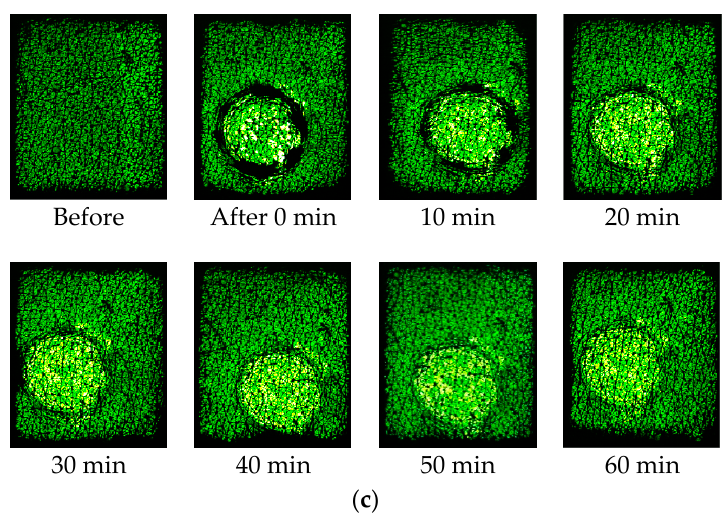
Figure 6. Capacitive contact images of skin before and after solvent applications, ( a ) Ethanol; ( b ) Ethylene Glycol; ( c ) Glycerol.